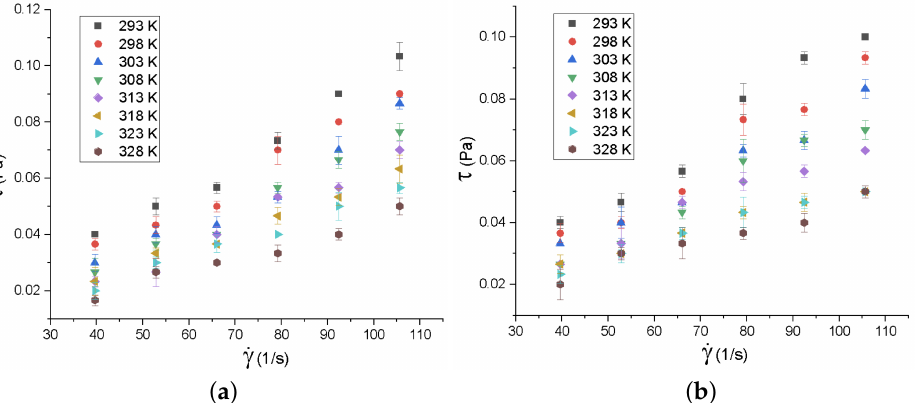
Figure 12. Rotational rheology of ( a ) MnO 2 AsA/rGO and ( b ) MnO 2 /rGO nanofluids. The error bars correspond to the measurements’ standard